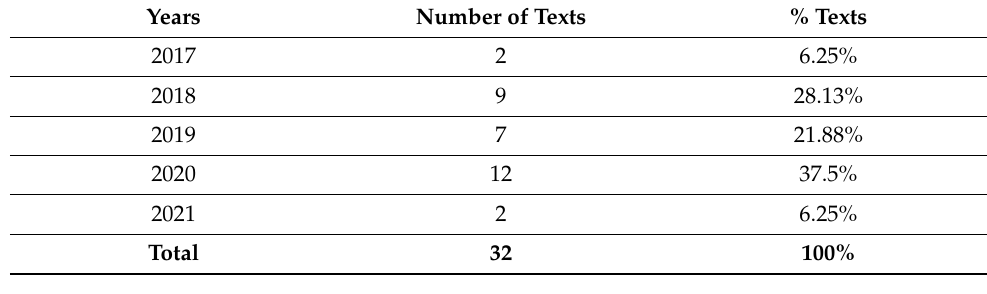
Table 2. Distribution of analyzed Papers by Year.